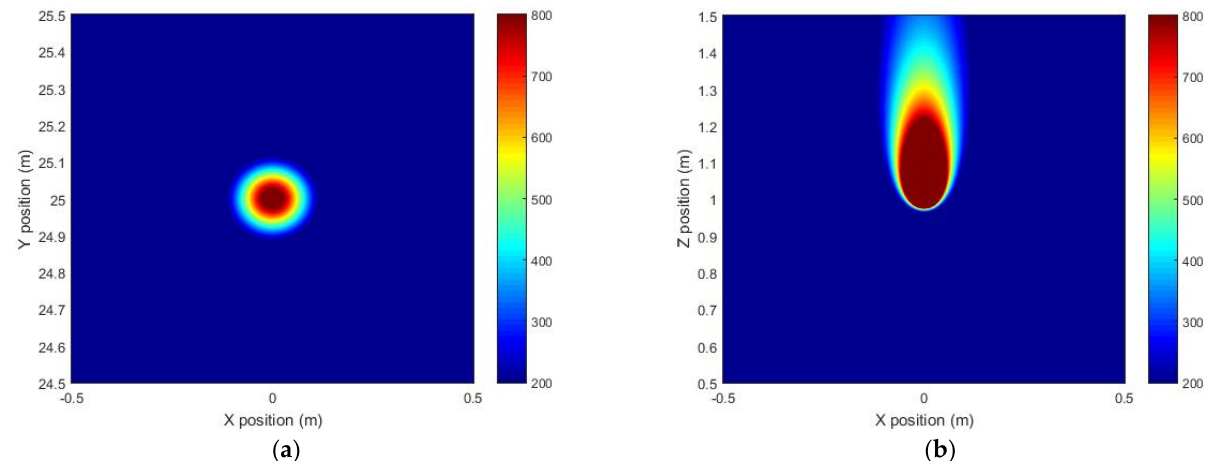
Figure 9. ( a ) The horizontal distribution of NH 3 concentration 0.2 m above the leakage source. ( b ) The vertical distribution of NH 3 concentration at the leakage source.